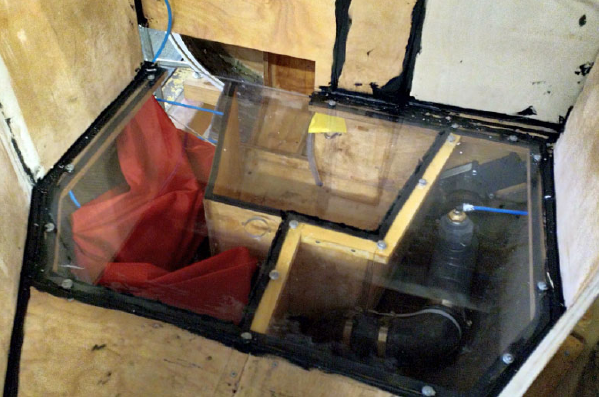
Figure A4. The red inflatable container for displacement of floodwater in compartment T045 during the assembly.